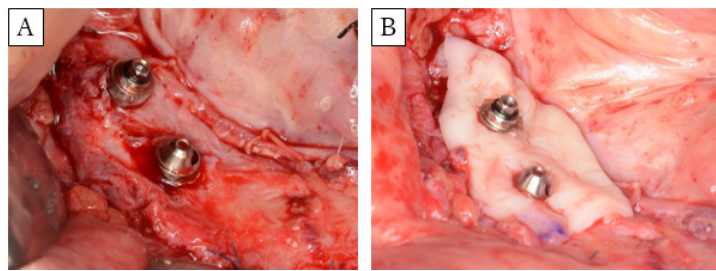
Figure 2. Images of FGG surgery. ( A ) Formation of a graft bed in a 10-mm region around the implant. ( B ) Grafting palatal mucosa to cover a 5-mm radius around the implant.